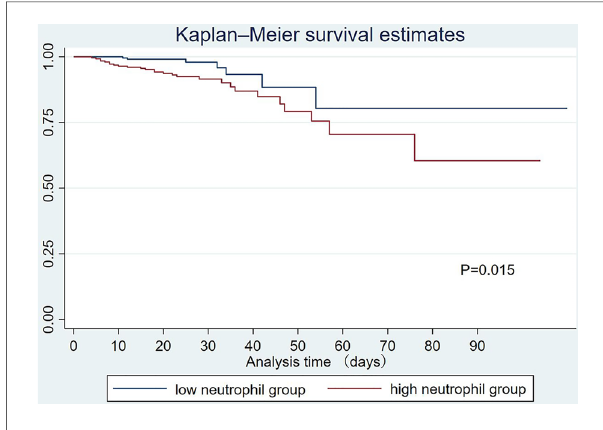
FIGURE 1 Kaplan-Meier analysis for in-hospital mortality by different neutrophil counts. The survival difference was signi fi cant ( P =0.015).